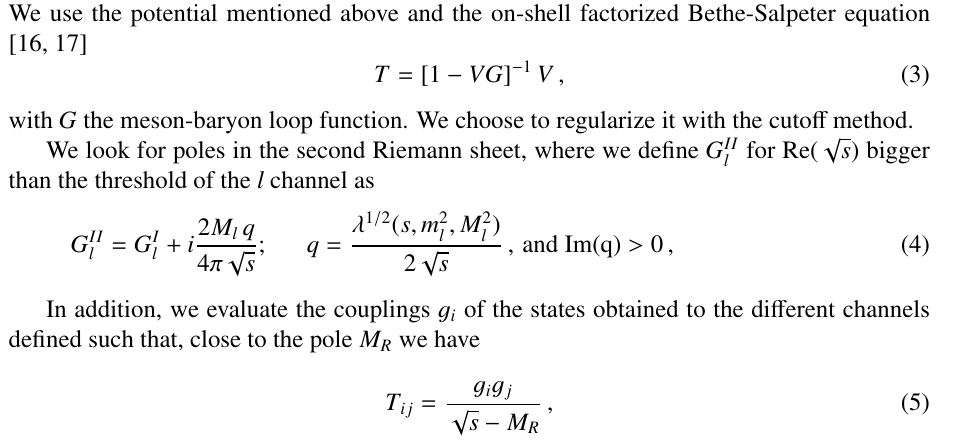
q = 650 MeV, and g max